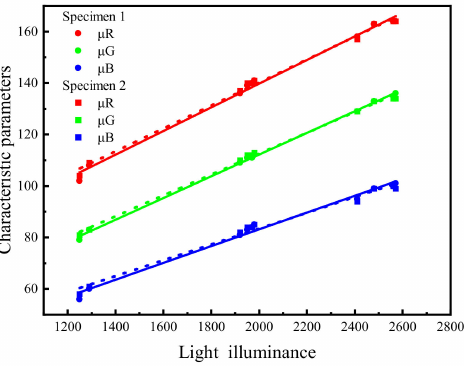
Figure 9. Characteristic parameters of soil image in RGB color space under different